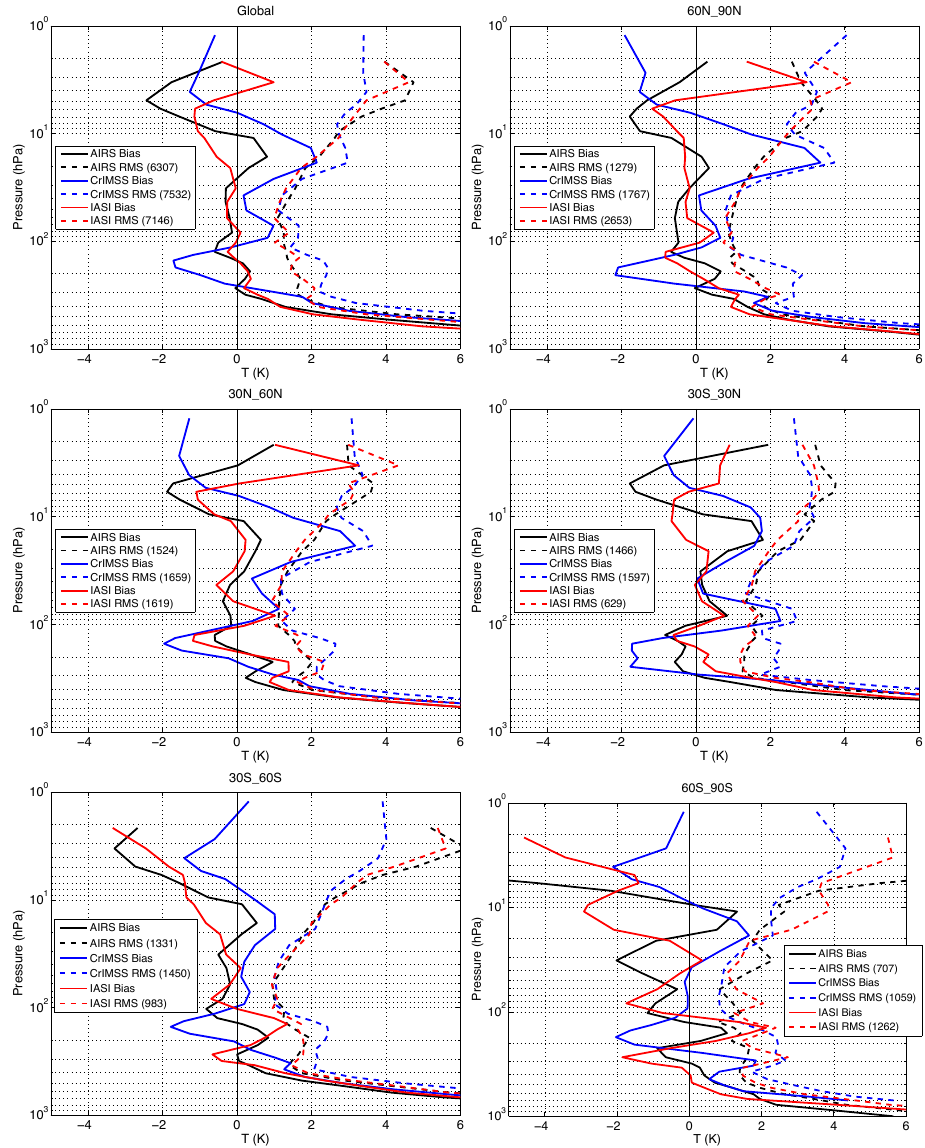
Figure 5. Bias (solid) and rms (dashed) error profiles from three operational sounder platforms (Aqua, Suomi NPP, and Metop-A) for May 2012 using COSMIC as a common reference. The three operational products shown are NASA AIRS v5.2 (black), NOAA IASI (red), and JPSS CrIMSS Mx5.3 (blue) for global and five latitude zones. The apparent large positive biases in the middle and lower troposphere are due to the comparison with the COSMIC dry temperatures, which are significantly lower than actual temperatures when significant amounts of water vapor are